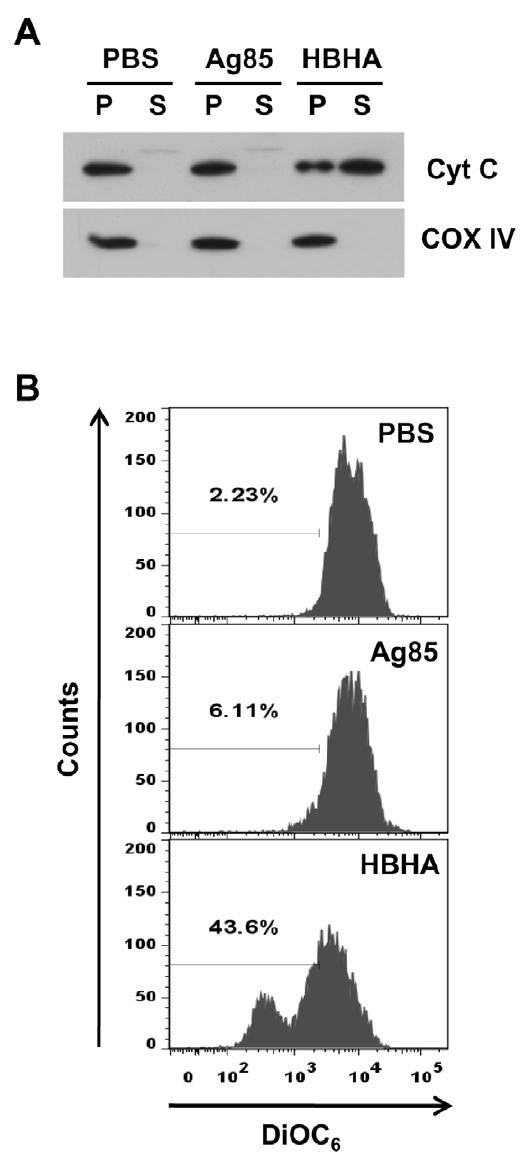
Figure 6. Effect of HBHA on cytochrome c release and DY m dissipation in mitochondria invitro . ( A ) Mitochondria were purified from RAW 264.7 cells and treated with HBHA (5 m g/mL), Ag85 (5 m g/ mL), or an equal volume of PBS for 1 h at 37 u C. The pellet (P) and the supernatant (S) of samples were then separated by SDS-PAGE and analyzed by Western blotting using antibodies against cytochrome c and COX IV. Results are from one of two independent experiments. ( B ) Purified mitochondria were stained with DiOC 6 for 20 min at 37 u C and analyzed by flow cytometry. Data are representative histogram plots taken from three separate